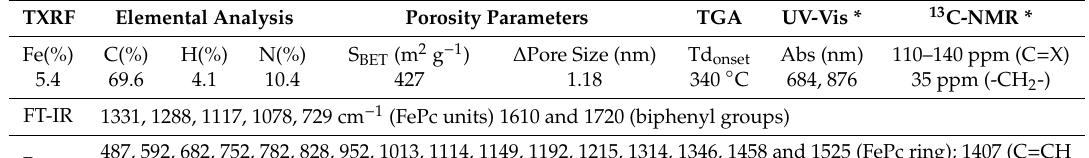
Table 1. Characterization data of